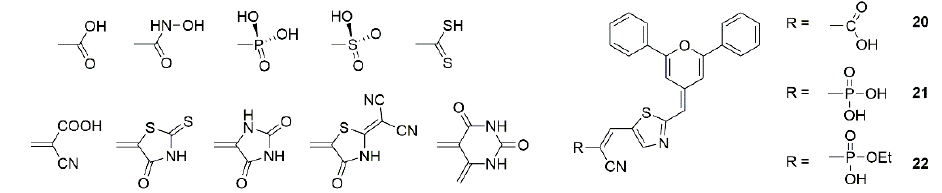
Figure 5. Chemical structures of anchoring groups and dyes 20 – 22 .